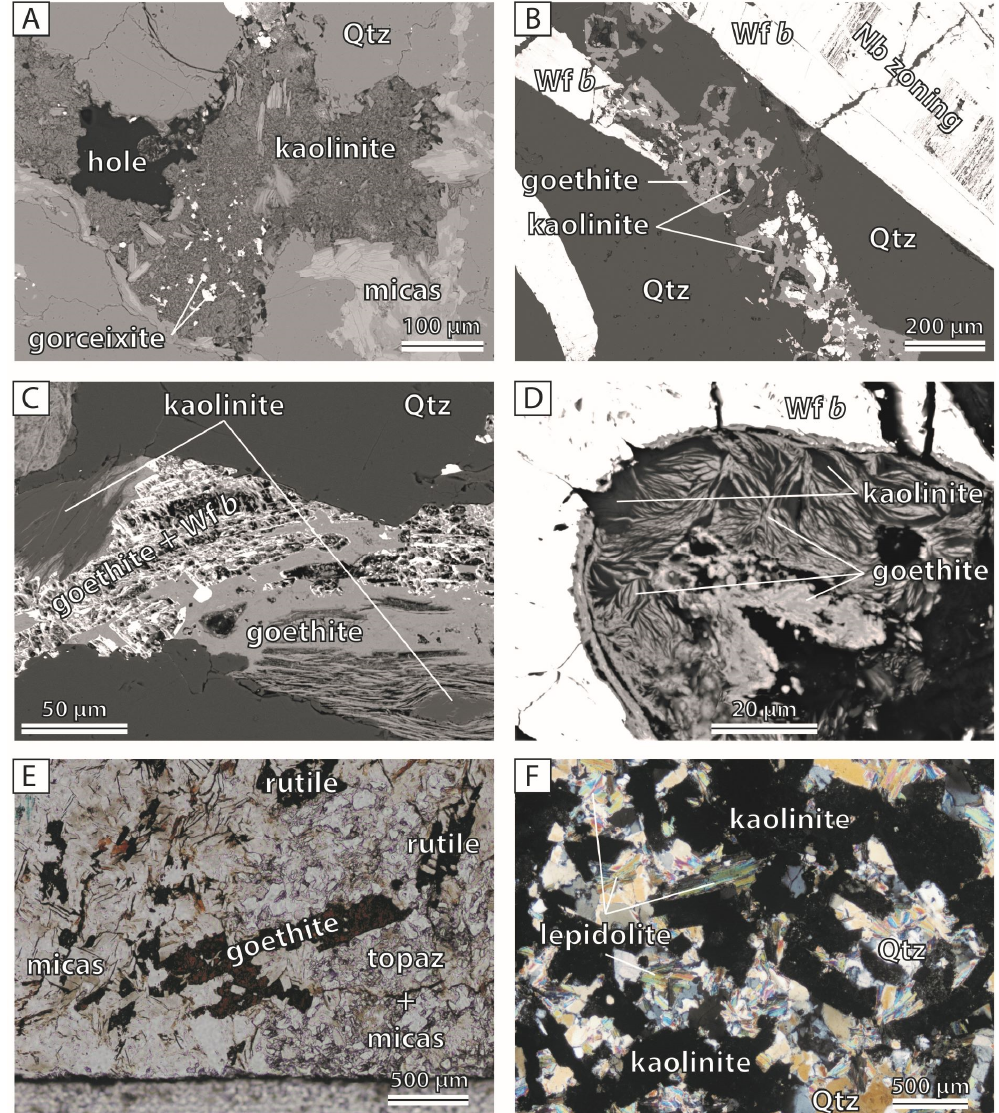
Figure 6. Photomicrographs illustrating the kaolinization assemblage in the La Bosse Stockwork quartz veins ( A to D ), metasomatized schist ( E ) and Beauvoir albitite dyke ( F ). ( A ): Kaolinite, with gorceixite, fills the porosity in a quartz vein (BSE). ( B )–( D ): Images at different scales illustrating gosts of wolframite b filled by goethite and kaolinite (BSE). ( E ): Goethite replacing wolframite b ; other minerals are unaffected (PPL). ( F ): Contrary to the Beauvoir main body, Beauvoir dykes commonly display kaolinite alteration without evidence of greisen alteration. Here, alkali feldspars are altered to kaolinite, which takes a rectangular shape (XPL; note, slightly thick section).